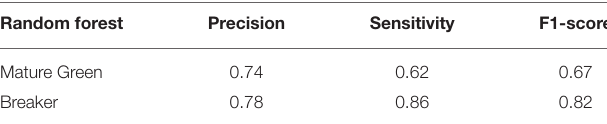
TABLE 1 | Precision, Sensitivity, and F1-score of the Random Forest model to Mature Green and Breaker classification. Random forest Precision Sensitivity F1-score Mature Green 0.74 0.62 0.67 Breaker 0.78 0.86